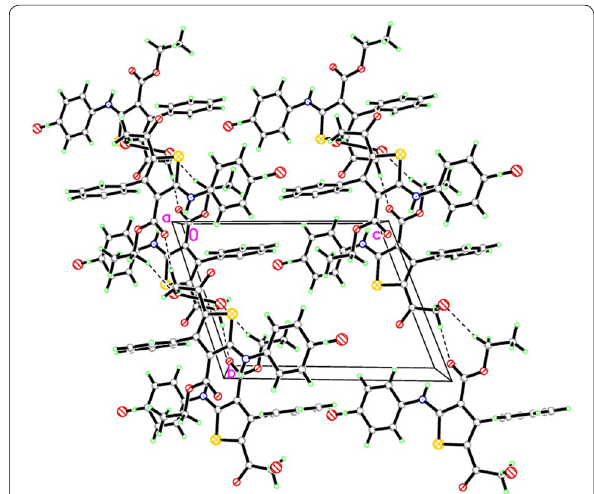
Fig. 4 A view along the b axis of the crystal packing of compound 2 . Dashed lines indicate week hydrogen bonds